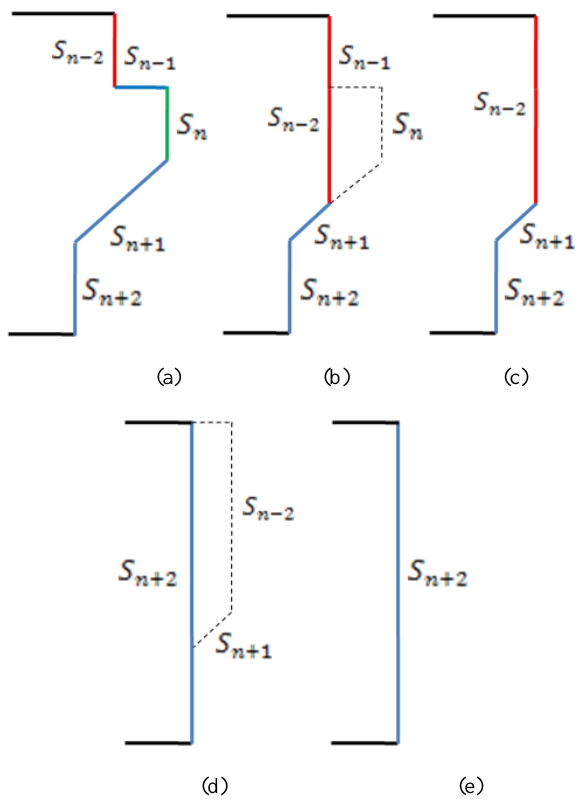
Figure 3. Simplification of asymmetrical edges of ground plan with two iterations. Result of 1 st iteration after removing shorter edges (c) and in 2 nd iteration, their transformation results (e) Case II: Adjustment based on